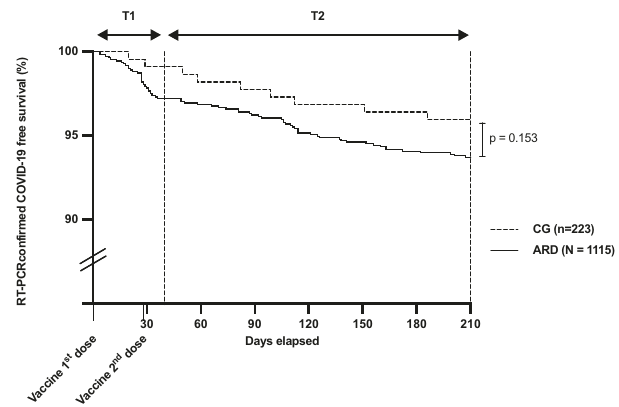
Fig. 2 | Kaplan – MeiercurvesofCOVID-19incident cases. The fi guredepicts real- time polymerase chain reaction (RT-PCR) con fi rmed COVID-19 cases in patients withautoimmunerheumaticdisease(ARD)andcontrols(CG).Allparticipantswere — — followed from the day of inclusion, which is the day of fi rst dose vaccination with CoronaVac vaccine (DO) up to 10 days after the second dose vaccination (T1). The secondperiodoffollow-up(T2)rangedfromT1to6monthsaftertheseconddose. Kaplan – Meier curves were compared with long-rank test and if p -value was <0.05 then the difference was considered signi fi